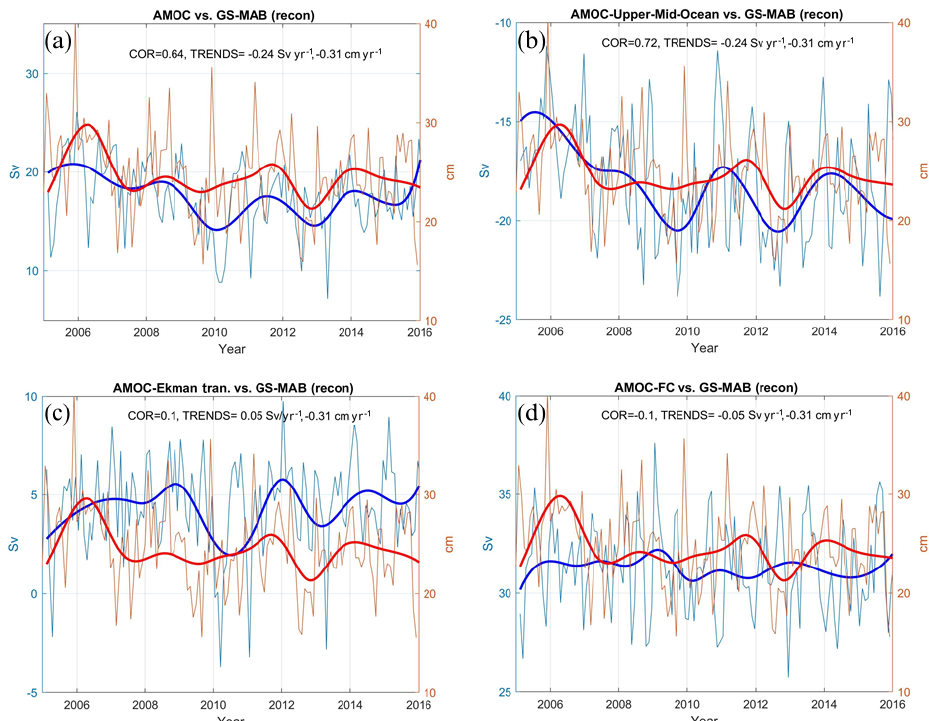
Figure 11. Comparison between the GS-MAB proxy and the RAPID observations: (a) total AMOC transport, (b) upper mid-ocean transport, (c) Ekman transport and (d) the Florida Current transport. The GS proxy (in blue) is the average north–south sea level change across the GS (in centimeters per 1 ◦ latitude) representing the eastward-flowing strength of the geostrophic surface flow; RAPID observations (transport in Sverdrups) are in red. Thin lines are monthly values, and the heavy lines represent the sum of low-frequency EMD modes. The correlation of the low-frequency modes and the trends of the monthly records are